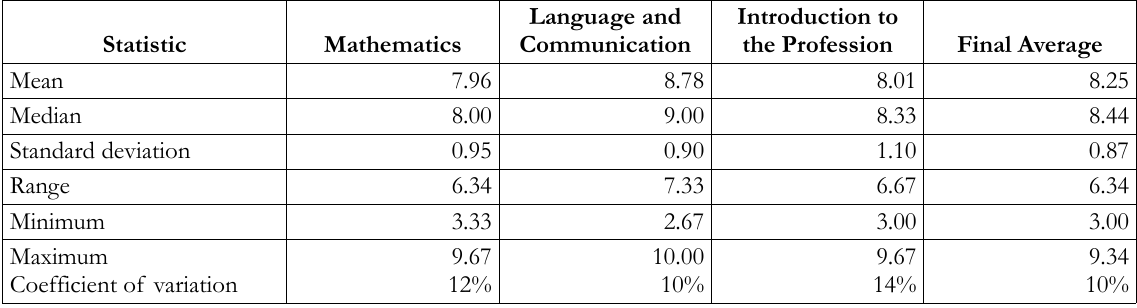
Table 1. Descriptive summary of the data